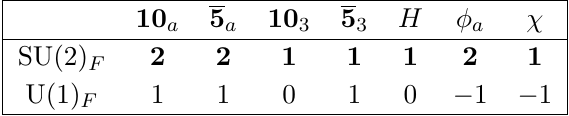
Table 1 . The (cid:12)eld content and U(2) F quantum